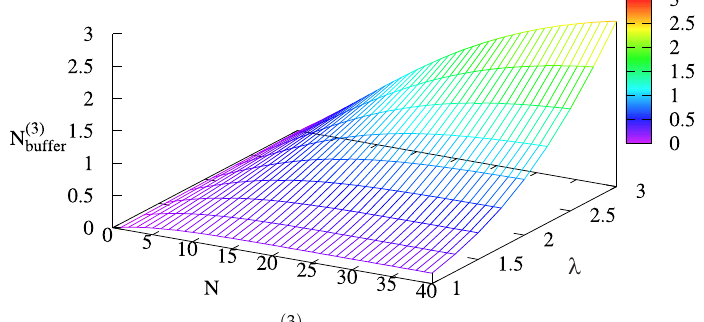
Figure 4. Dependence of N